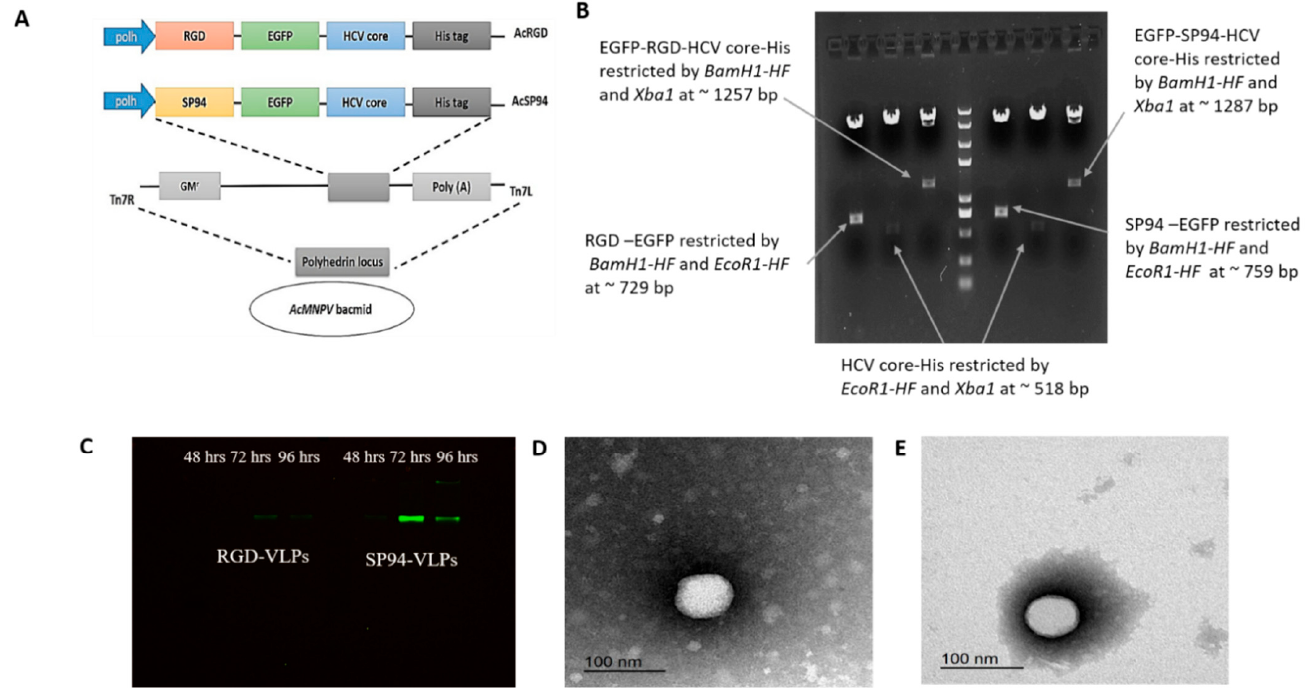
Figure 1. Construction and characterization of SP94-core protein and RGD-core protein: ( A ) repre- sents the strategy for insertion of the two cloning cassettes into the polyhedrin locus of the AcMNPV bacmid; both cassettes were inserted into the attb site (indicated by the right and left insertion sites, Tn7R and Tn7L) in the polyhedrin locus by Tn-based transposition to generate the recombinant bacmids; ( B ) represents the digestion results of pSP94-core and pRGD-core by different restriction enzymes; ( C ) represents in-gel fluorescence results for SP94-core protein at 47.86 KDa and RGD-core protein at 47.86 KDa; ( D ) TEM of RGD-core protein; ( E ) TEM of SP94-core protein; TEM showed the VLPs sizes at 30 nm to 60 nm, which is the expected range of